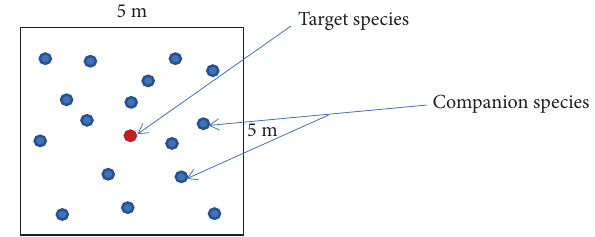
Figure 1: Flora sampling